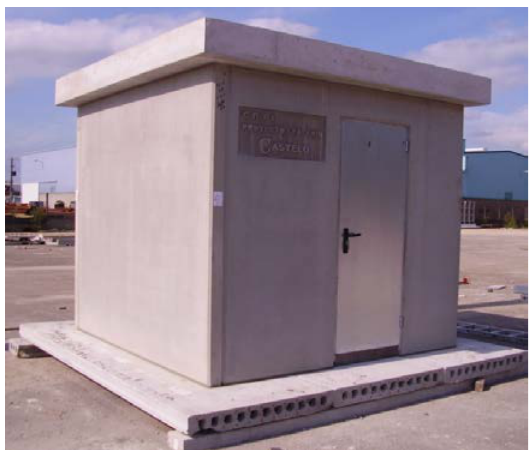
Figure 1. Experimental